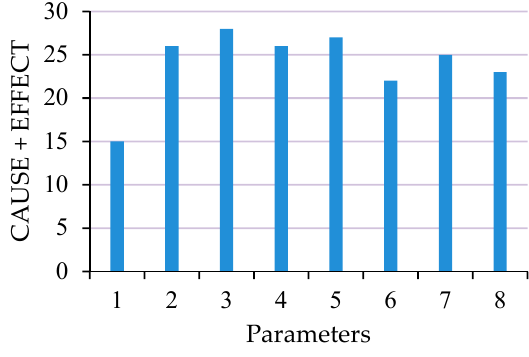
Figure 8. Histogram of interactive intensity.